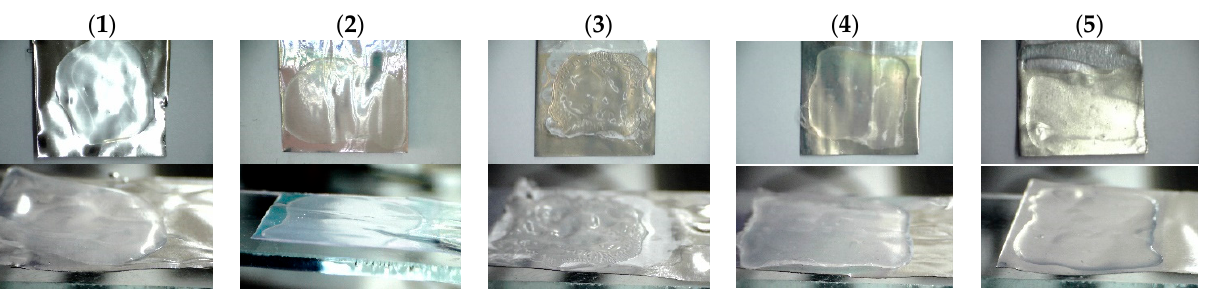
Figure 8. Water contact angle dependence of nanoperforation average diameters, 1–untreated ano- dized aluminum, 2–modified aluminum.